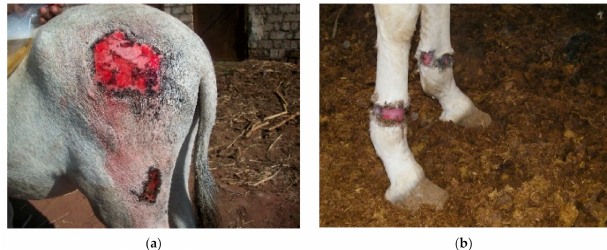
Figure 3. ( a ) Body condition was assessed using a scale of 1 (poor) to 5 (obese). The donkey in ( a ) would be considered to have a good body condition (3) and no wounds, and the donkey in ( b ) would be considered to have a poor body condition (2) and multiple lesions from the harness and excessive